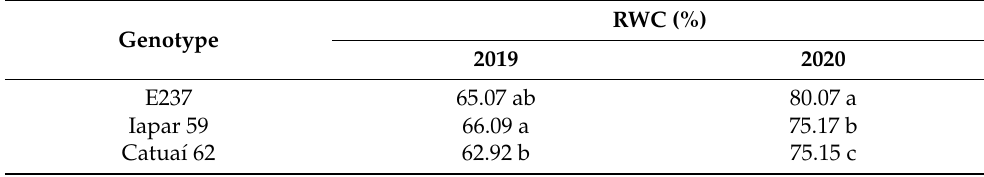
Table 3. Relative water content (RWC) in coffee arabica genotypes (E237, Iapar 59 and Catua í 62), after the return of irrigation in 2019 and 2020.